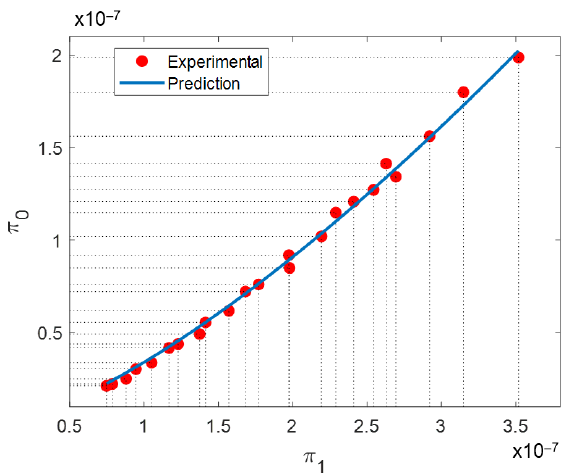
Figure 9. Plot of π 0 vs. π 1 using experimental data collected by Kempen et al. in [59] during the fabrication of metallic samples made from AlSi10Mg alloy.